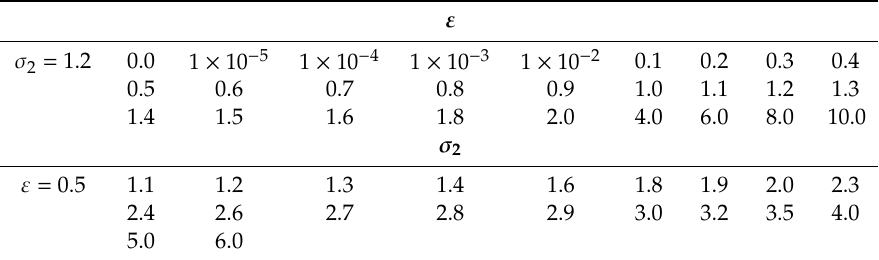
Table 1. Pairs of interaction intensity, ε , and range, σ 2 , as studied in the present work for the 100-chain N = 12 system at φ = 0.05 and k B T =